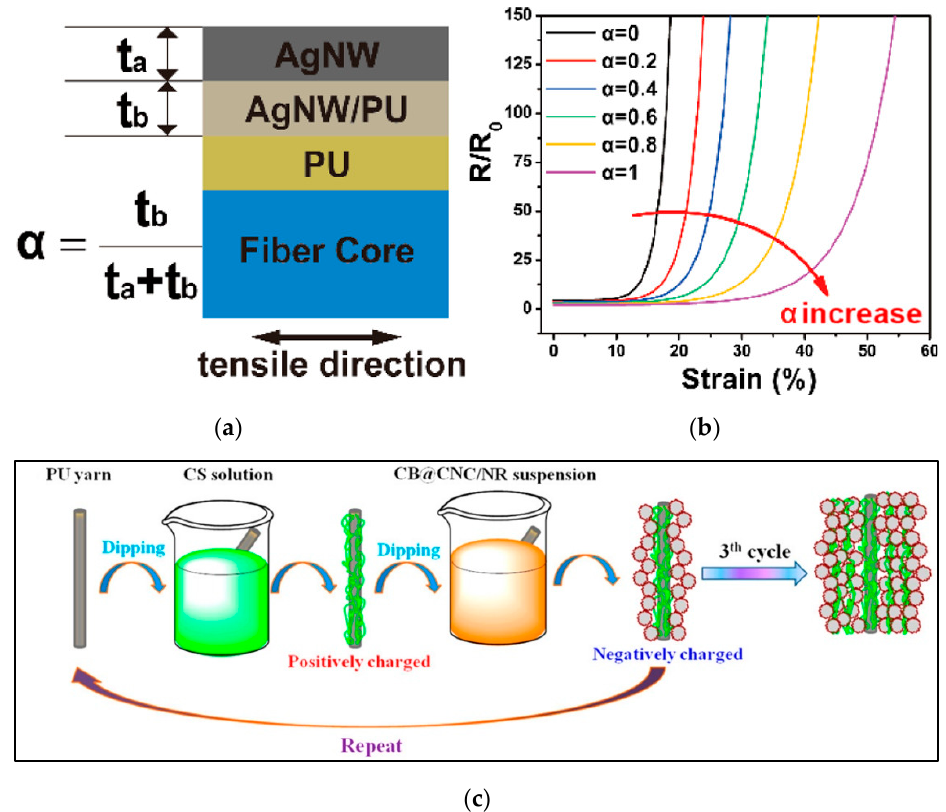
Figure 7. ( a ) Schematic diagram of the longitudinal section of Ag NW/PU fiber ( b ) Modeling of the resistance change and strain of Ag NW/PU fiber with different interface bonding strengths [91] ( c ) Schematic of the preparation of CPC@PU yarn by the LBL assembly process